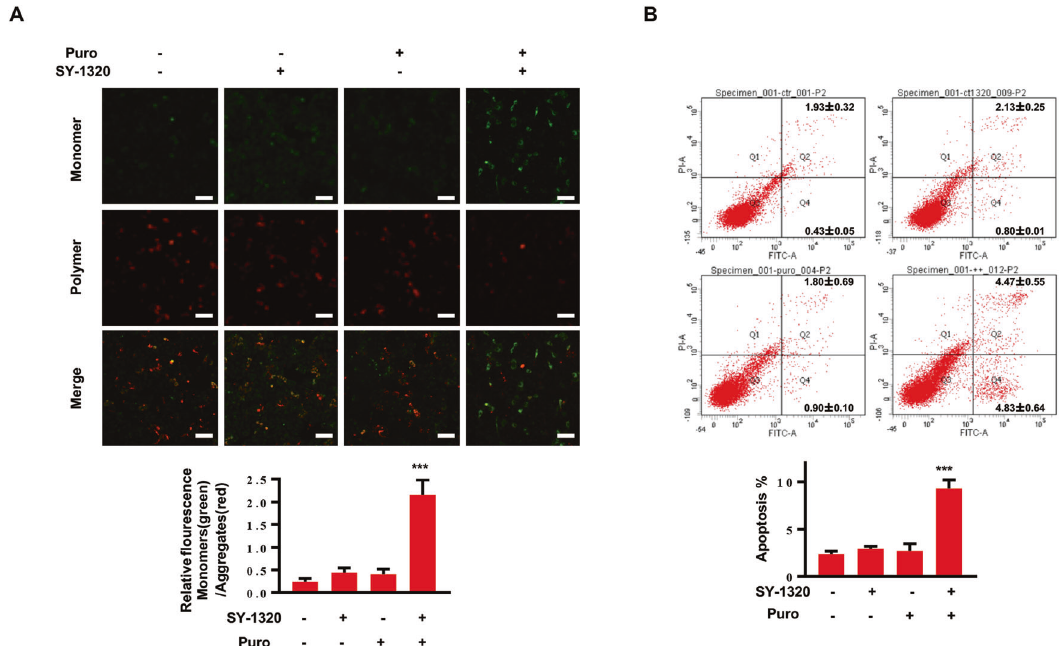
Fig. 4 Combination of SY-1320 and puromycin synergistically induces apoptosis in MCF-7 ADR cells. A MCF-7 ADR cells were treated with Puro (1 µg/mL), SY-1320 (2 µM) alone, or both for 24 h, followed by JC-1 staining. Scale bars, 50 µm. B MCF-7 ADR cells were treated with Puro (1 µg/mL), SY-1320 (2 µM) alone, or both for 48 h. The cell apoptosis was detected by fl ow cytometry. Data are presented as mean ± SD of three independent experiments. *** P < 0.001, two-tailed Student ’ s t (Fig. 6E, TQ as a positive control and CB-839 as a negative control). Taken together, compound 968 and SY-1320 promoted the accumulation of ADR in MCF-7 ADR cells by inhibiting P-gp.